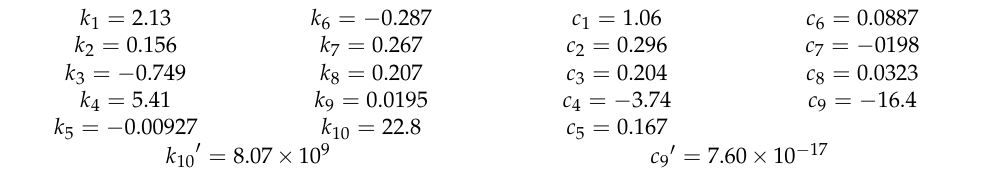
Table 4. Coefficients corresponding to Equations (11) (kx) and (12) (cx).